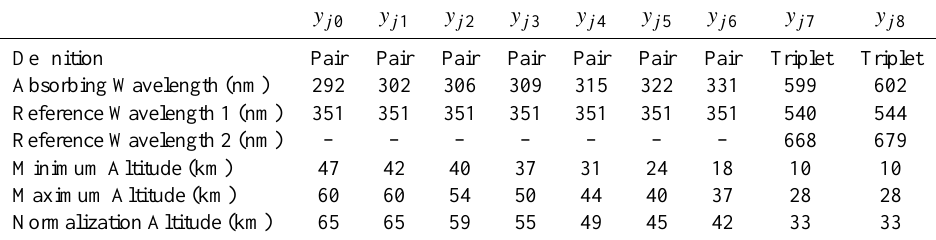
Table 1. Definitions of the 9 pair/triplet combinations calculated from the measured limb radiances shown in Fig. 1 that are used to construct the measurement vector, y jk . The normalization altitude for each wavelength in a triplet or pair is the same. y j 0 y j 1 y j 2 Definition Pair Pair Pair Pair Pair Pair